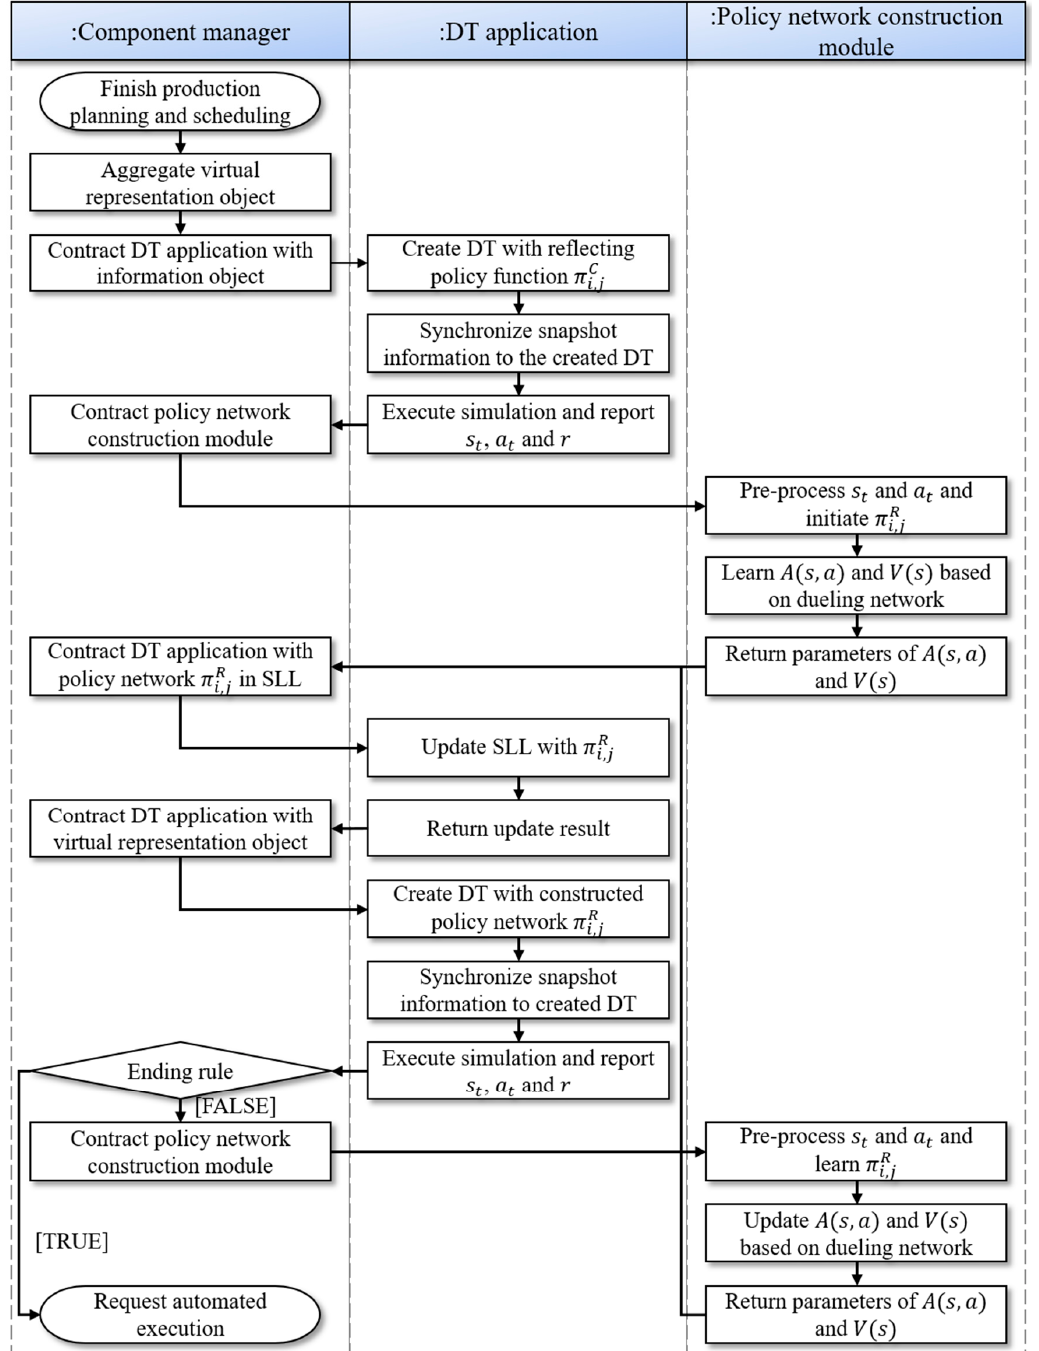
Figure 4. Service composition procedures for enabling policy network (Revised from Park et al. [19]).